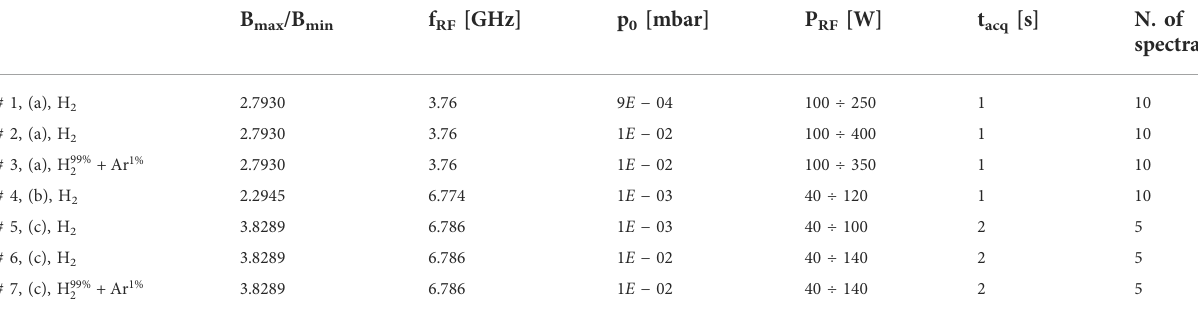
RF = 6.786, at 140 W, and p 0 =